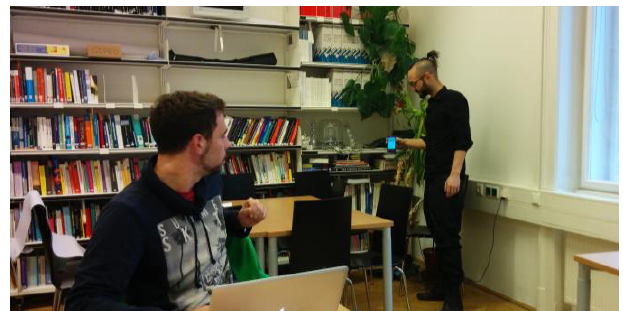
Figure 2. Triggering sounds of spatially distributed smartphones